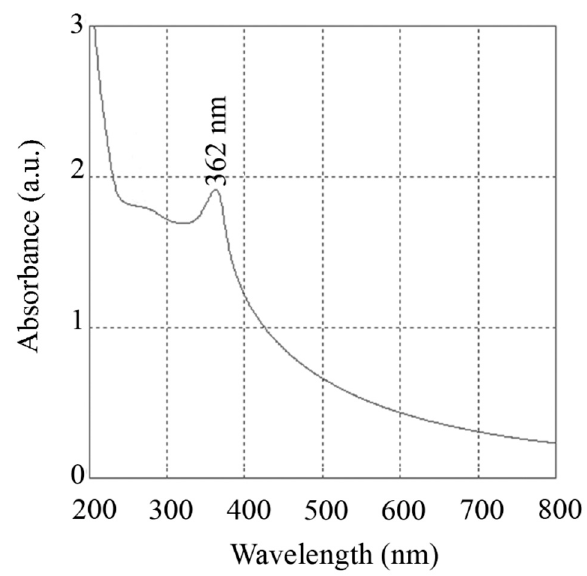
Figure 5. UV-Vis spectrum of the prepared ZnO nanorods, exhibiting an absorption peak at 362 nm.